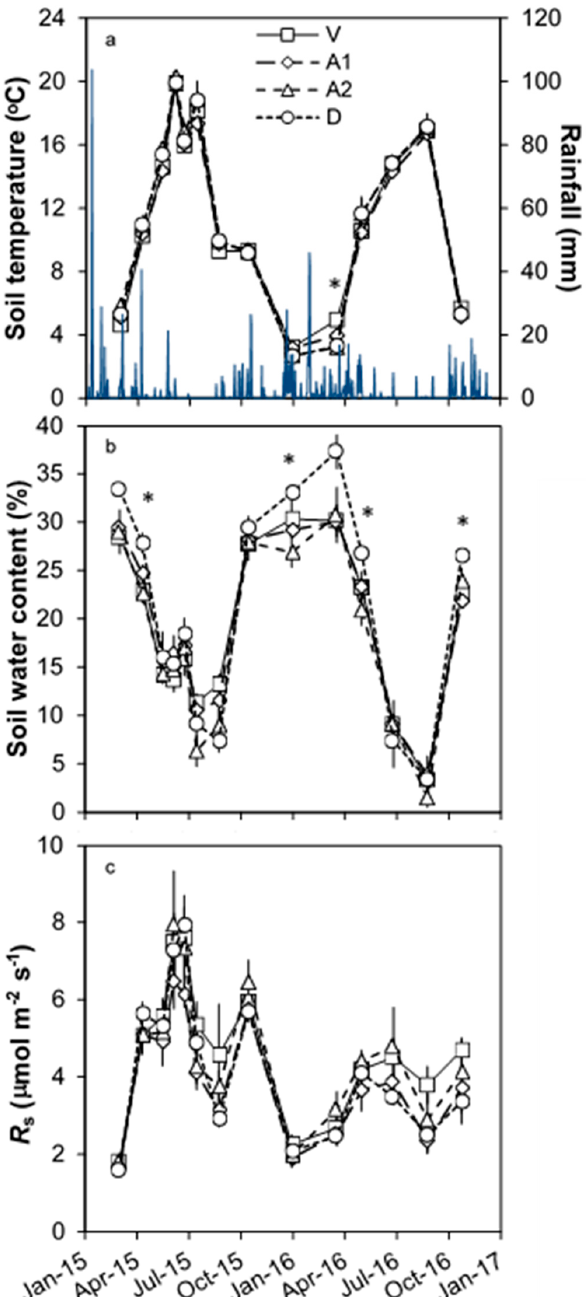
Figure 2. Temporal changes in ( a ) soil temperature and daily rainfall (blue line), ( b ) soil water content at 0–20 cm depth, and ( c ) soil respiration ( R s ) around centennial beech trees of di ff erent decline